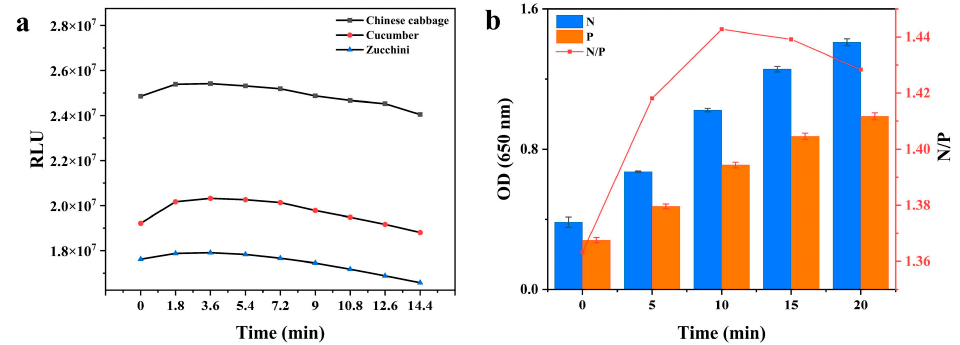
Figure 4. ( a ) The dynamic curve of Cl-ELISA in the three tested vegetable samples from 0 to 14.4 min with no analyte. ( b ) Absorbance values for optimization of reaction time (0, 5, 10, 15, and 20 min) for